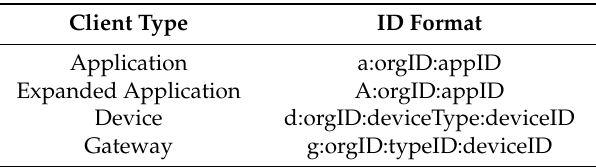
Table 3. Type of Watson IoT client ID.